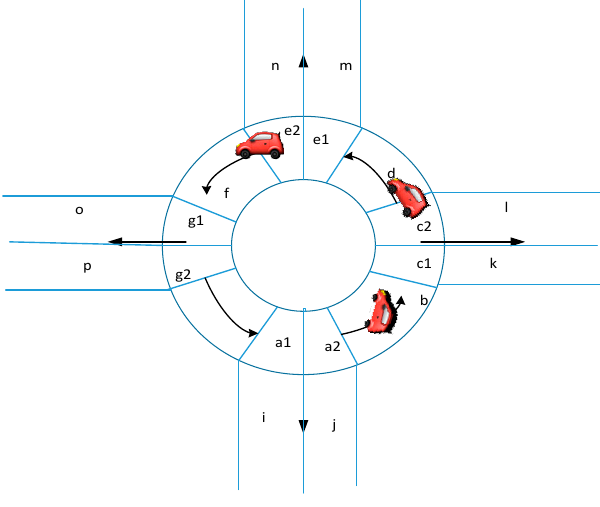
Figure 2. Single ‐ loop diagram. Figure 2. Single-loop